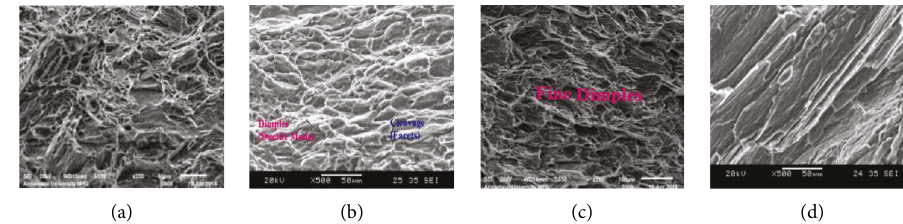
Figure 10: SEM fractograph of unnotched tensile specimen. (a) CCGTAW. (b) PCGTAW. (c) MAO. (d) BASE METAL.